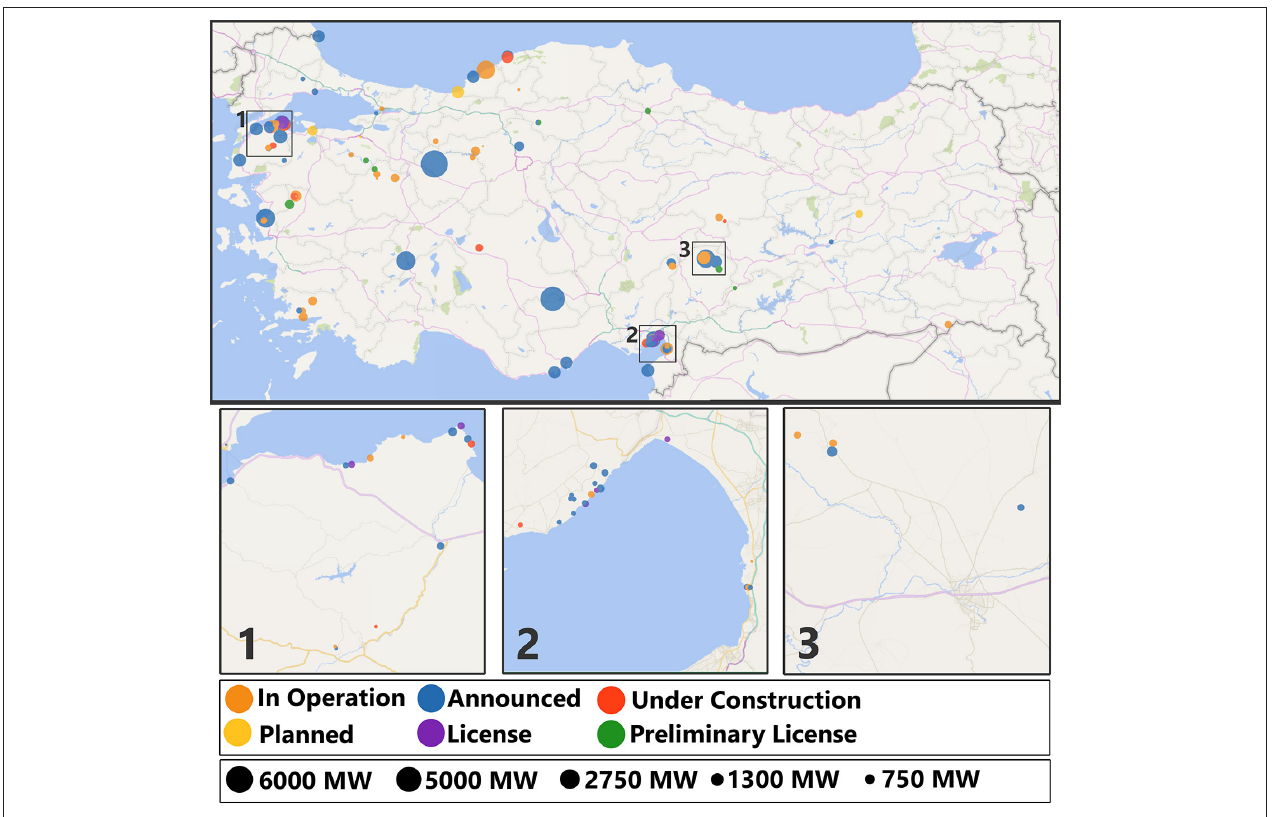
FIGURE 5 | Planned and operating coal power plants in Turkey ( Source: own elaboration, using data provided by TEMA Foundation 15